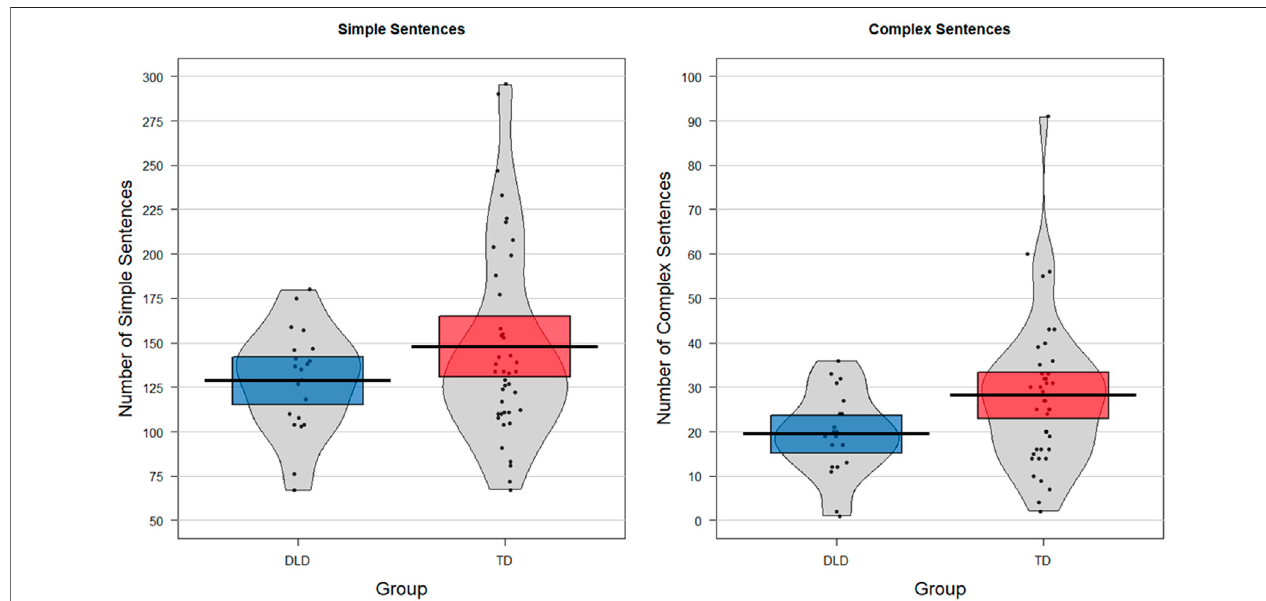
FIGURE 1 | The number of simple (A) and complex sentences (B) produced by children in each group across the conversation and narrative task. 1) The scale is different for the two fi gures, as children produced more simple than complex sentences on the language production tasks; 2) The thick black linerepresents the median for each group, the colored rectangle is the interquartile range; and the grey shape represents the distribution of all data points, with greater width indicating a higher frequency of data points in that region.